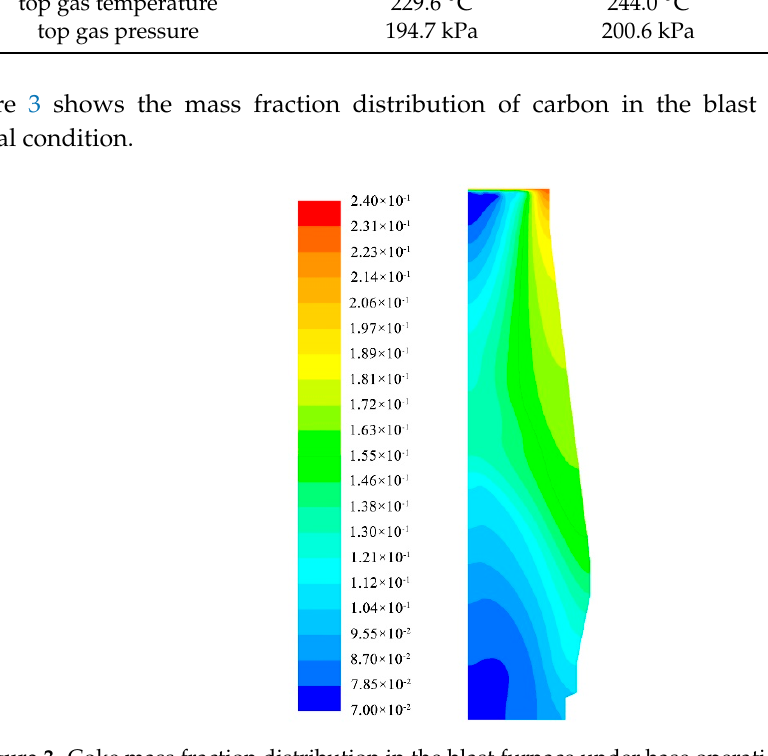
Figure 3. Coke mass fraction distribution in the blast furnace under base operational condition.